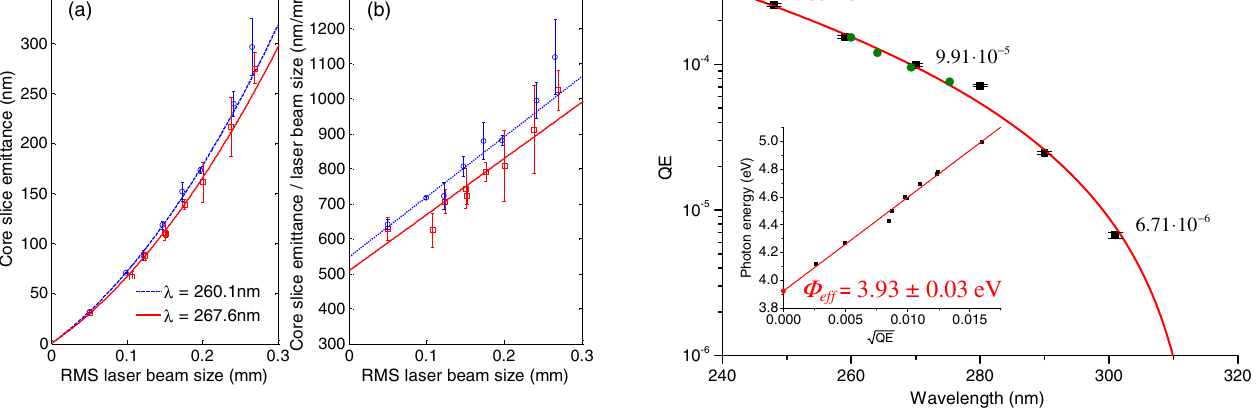
FIG. 4. Quantum efficiency as a function of wavelength with Cu_3 cathode. Numbers are shown at the two extremes and at the nominal wavelength (248, 270, and 301 nm). Measurements were taken with both the 3rd harmonic of the Ti:sapphire laser 3rd harmonic (green dots) and the OPA (black squares) covering a total wavelength range of 248 – 301 nm. The fit based on Eq. (4) (inset) gives an effective work function of 3.93 eV (red